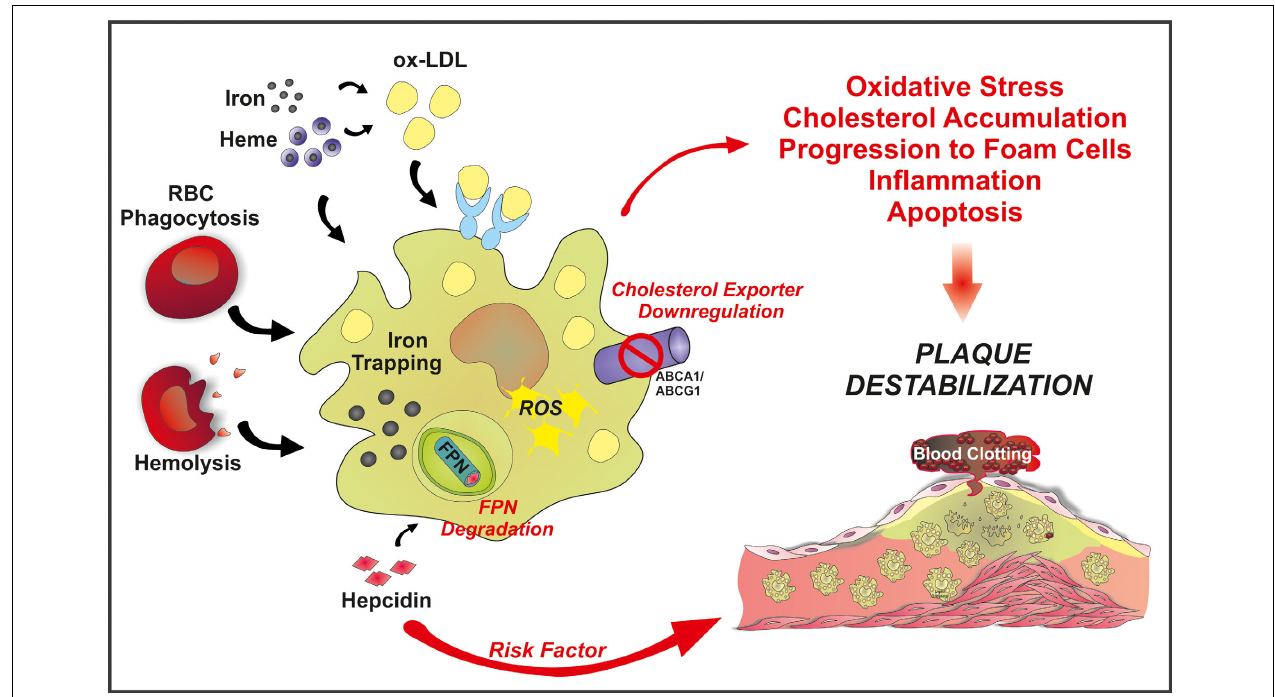
FIGURE 2 | Schematic overview of the “refined iron hypothesis”: a role for macrophage-retained iron in atherosclerosis. Iron can accumulate in macrophages as inorganic iron and Hb-iron, upon erytrophagocytosis or hemolysis. Once stored in the cell, iron can be made available to the bloodstream via FPN-mediated export. According to the refined iron hypothesis, high hepcidin levels are